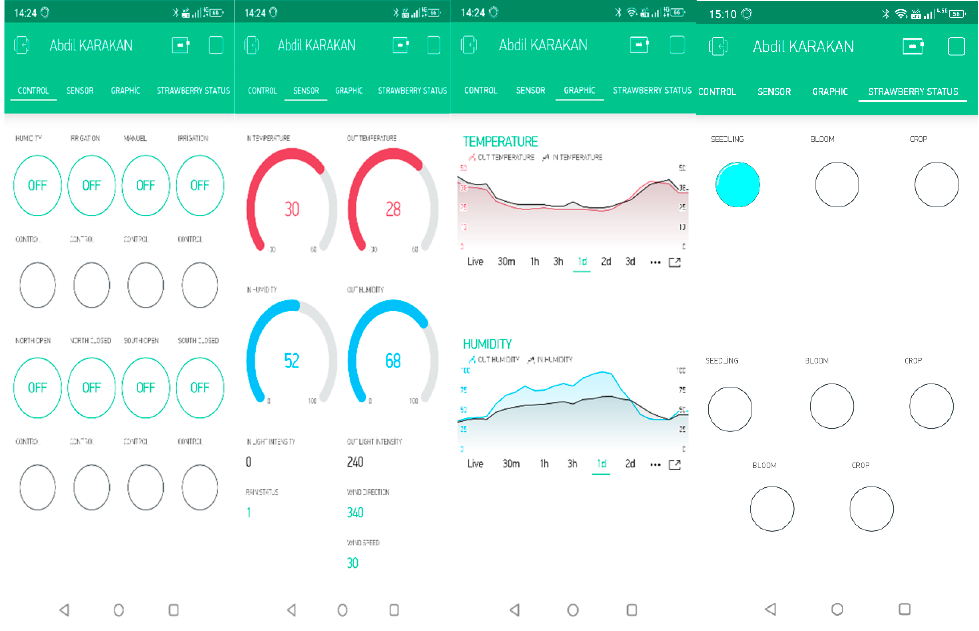
Figure 11. Control, sensor, graphic, and strawberry status interface display of mobile